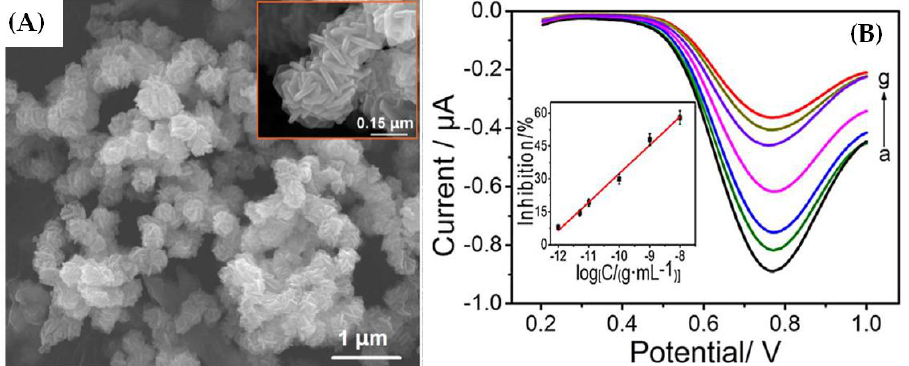
Figure 3. ( A ) SEM images of NiCo 2 S 4 ; and ( B ) differential pulse voltammetry response of the biosensor for concentrations of methyl parathion between 0 and 10 ng mL −1 (Reprinted from Peng et al. [15], Copyright (2017), with permission from Elsevier).